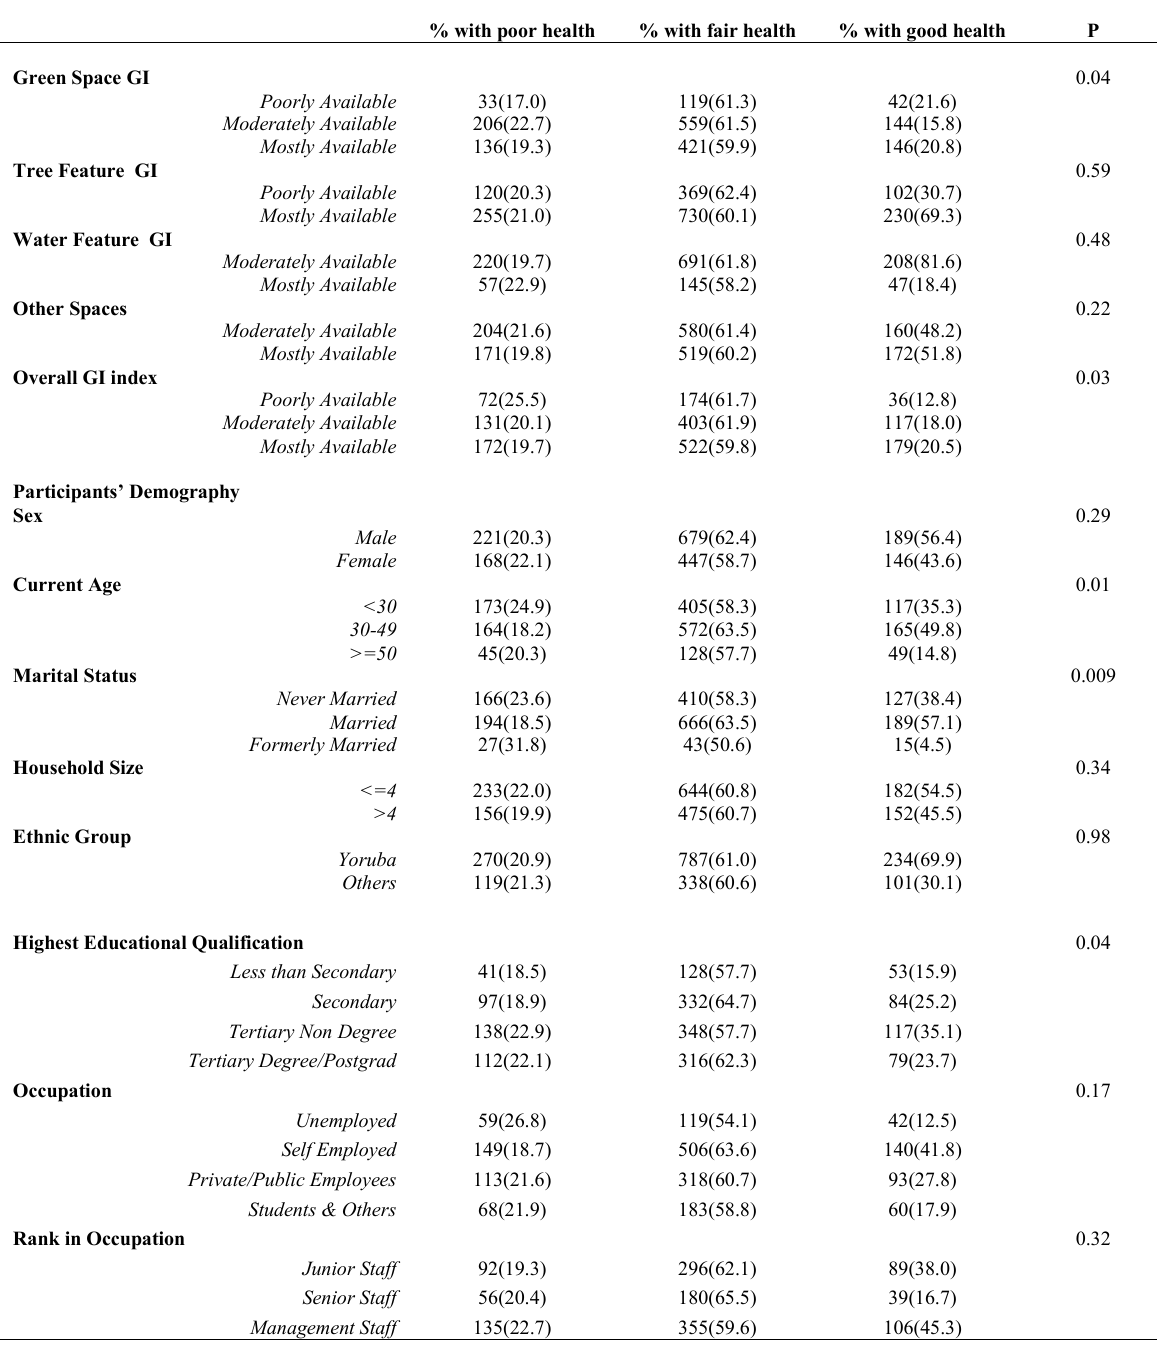
Table 2: Factors associated with perceived Health Benefits of Green